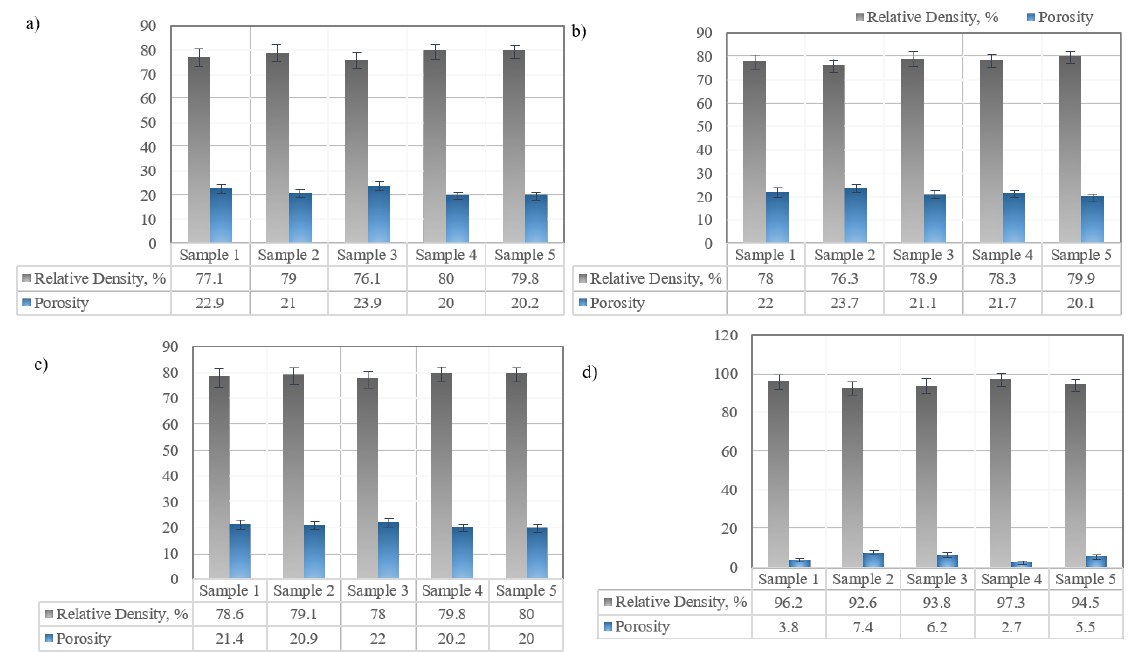
Figure 3. Variation of relative density of the different samples; ( a ) Specimen #2; ( b ) Specimen #3; ( c ) Specimen #4; ( d ) Specimen #5.